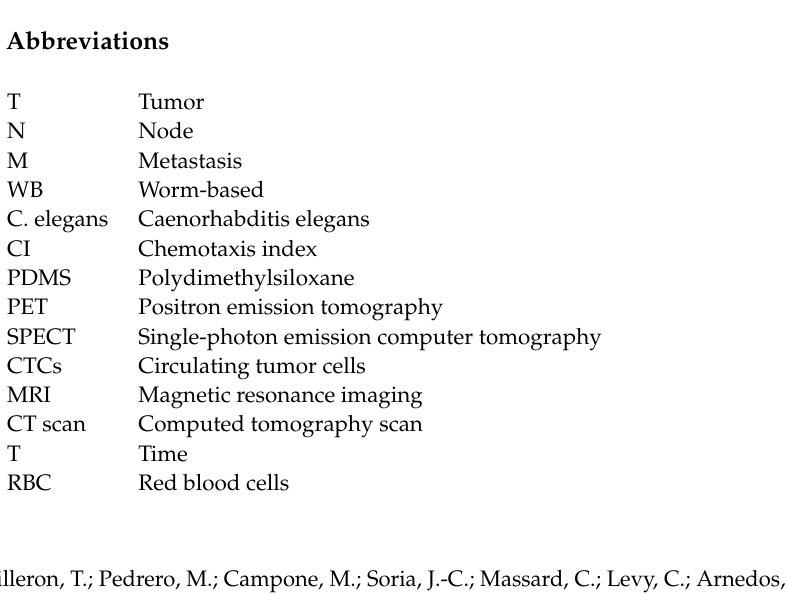
experimentation, Figure S4: Cluster area of cultures at various cell seeding concentrations. Table S1: Cancer detection